Question: What visual encoding does this figure use to show its data?
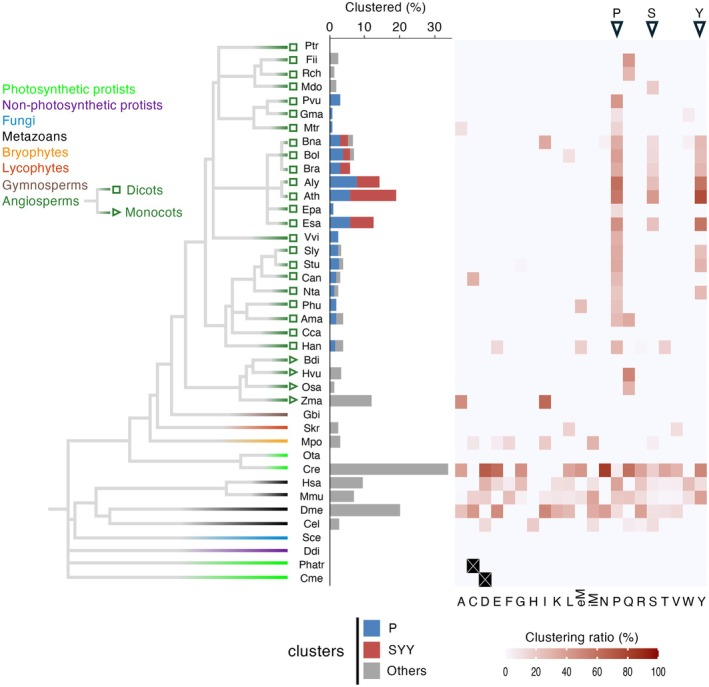
Answer: heatmap